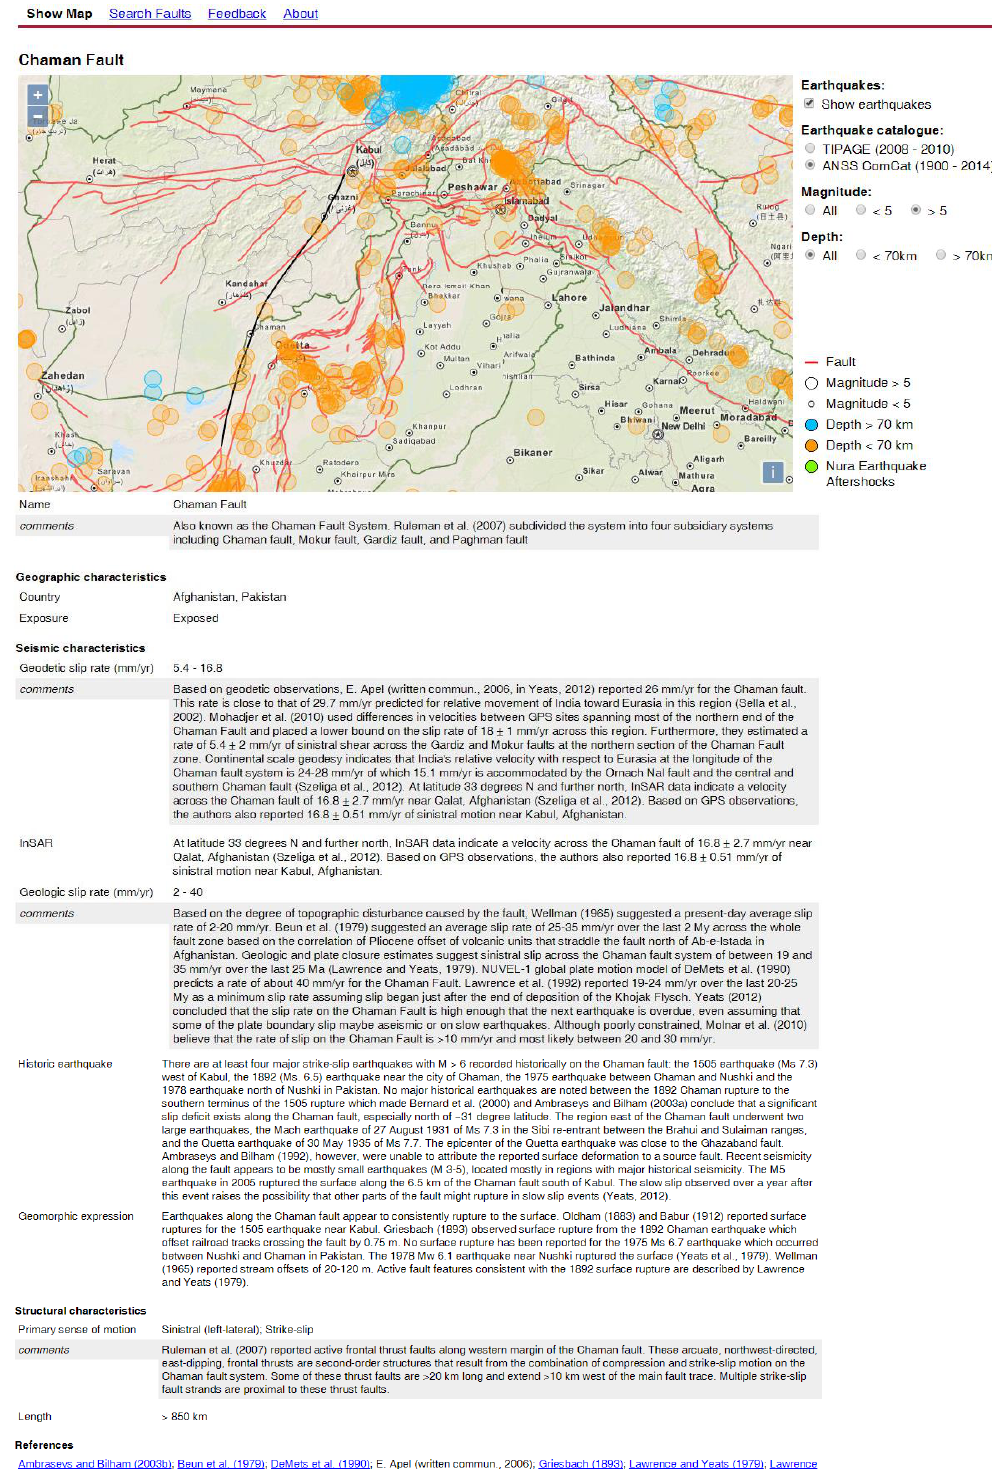
Figure 6. An example of a fault information page. The location map on top shows the selected fault in black (i.e., Chaman Fault). The fault description appears below the map. The description is organized into three distinct sections (i.e., geographic, seismic, and structural characteristics) with references linked to Google Scholar. Users can display earthquake data to visualize recorded seismicity in relation to the selected